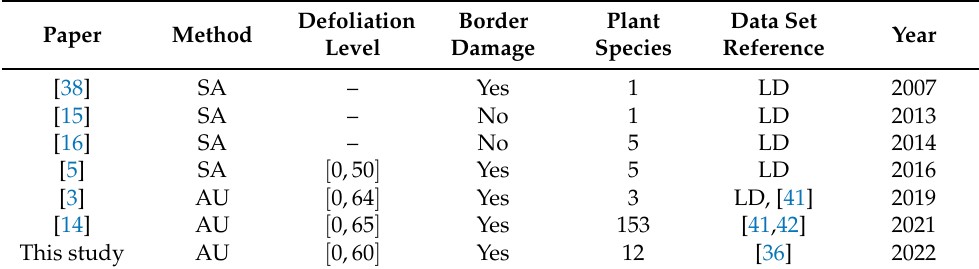
Table 2. Some relevant information about our method and related